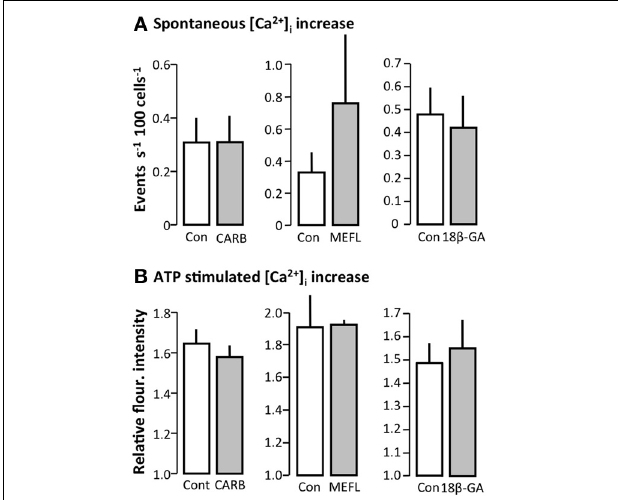
FIGURE 4 | Effect of gap junction and pannexin inhibitors on spontaneous [Ca 2 + ] i events in MDCK cells. (A) Carbenoxelone (CARB, 100 μ M, n = 7), mefloquine (MEFL, 100 μ M, n = 2) and 18 β -Glychyrritinic acid (18 β -GA, 50 μ M, n = 12). (B) Corresponding reactivity to ATP (100 μ M).